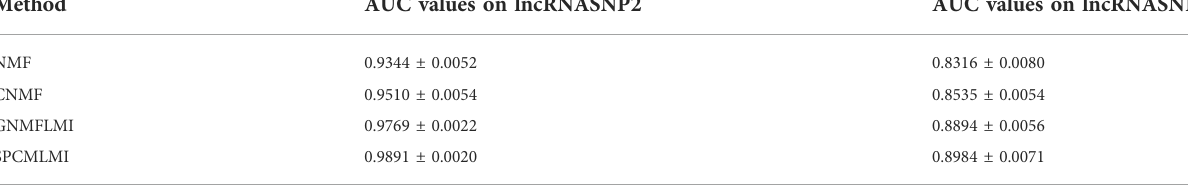
TABLE5AUCvaluesofSPCMLMIandothercomparedmethodsunder fi ve-foldcross-validation onthe lncRNASNPdataset andlncRNASNP2 dataset.